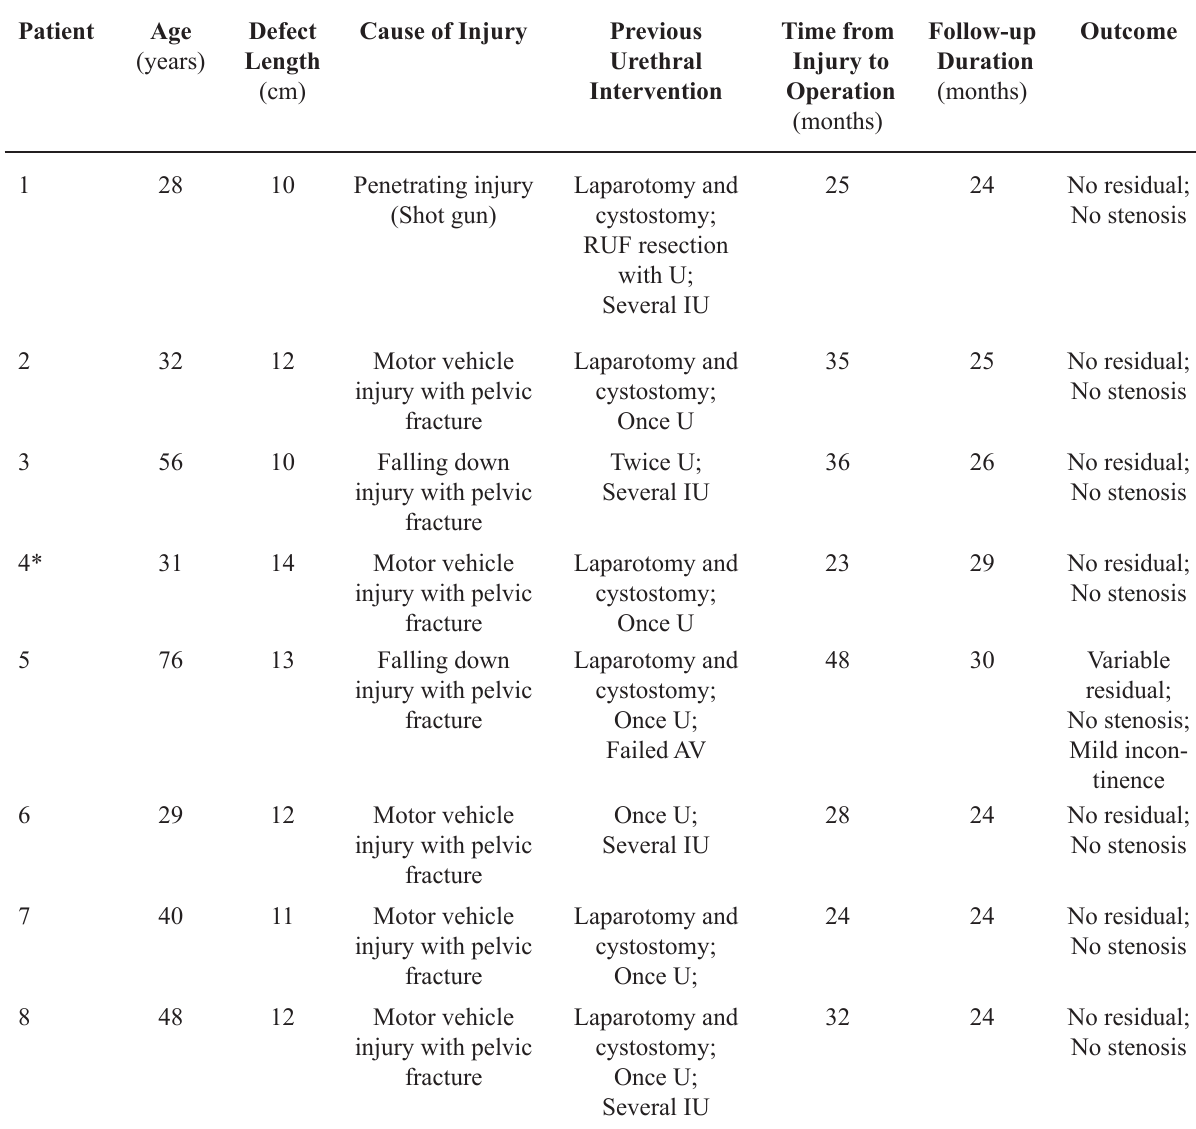
Table 1 – Patients’ general data, operative procedures and